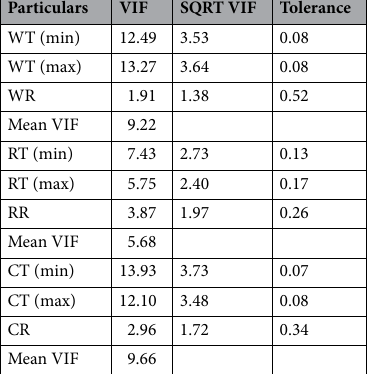
Table 2. Multicollinearity statistics. WT, RT, and CT represent the Wheat temperature, Rice temperature, and corn temperature, respectively. WR, RR, and CR represent the Wheat rainfall, Rice rainfall, and Corn rainfall, respectively. VIF represents Variance inflating factor, and SQRT VIF is square root of